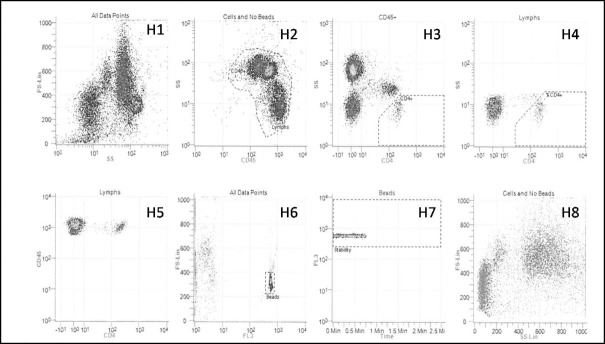
PLG/CD4 protocol on Aquios CL cytometer.PLG/CD4 gating strategy applied for the Aquios CL cytometer platform, represented by 8 histograms (H1-8). H2 selects all CD45 positive white cells, from which all CD4 bright lymphocytes are gated (in H3) for reporting of an absolute CD4 count, while a CD4% of lymphocytes value is derived from H4. H6 and H7 indicate the bead population, currently used as an internal control measure of instrument stability.